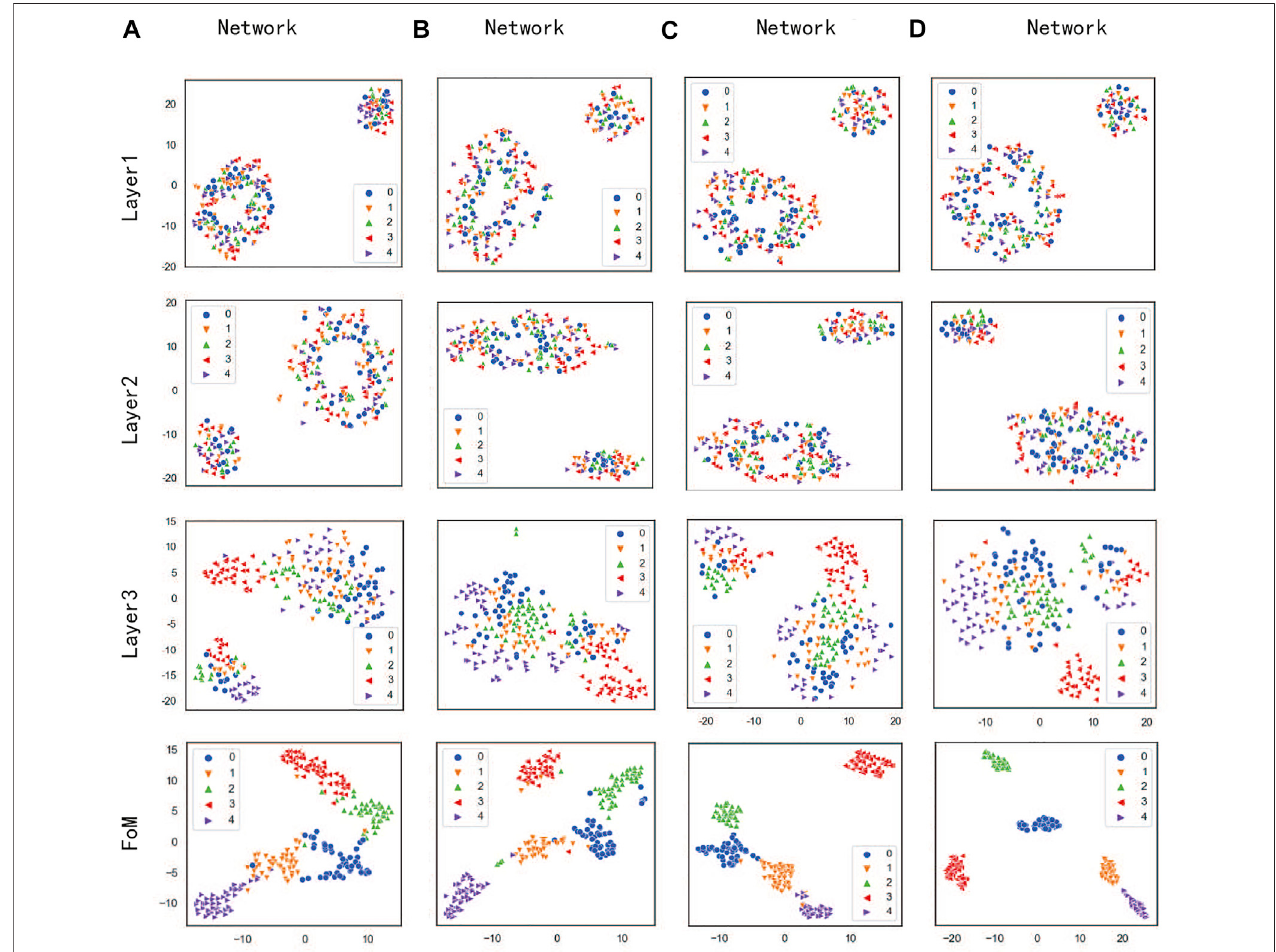
FIGURE 10 | The visual results by t-sne of different layers from networks.